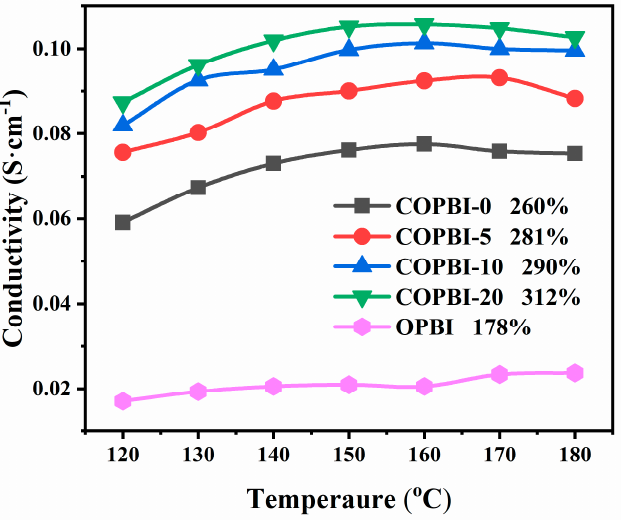
Figure 7. Proton conductivity of OPBI and COPBI membranes at saturated absorption.